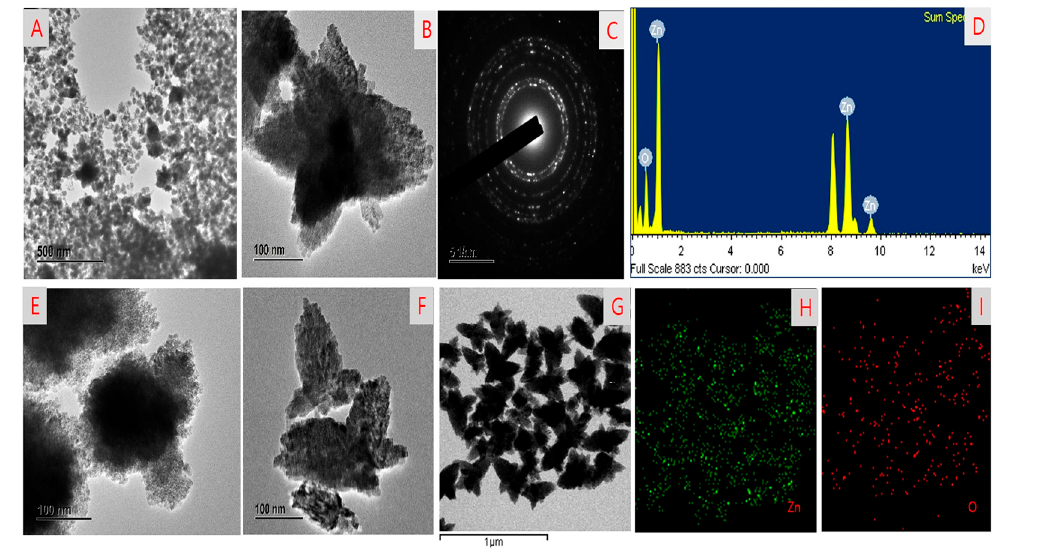
Figure 2. FE-TEM images showing the morphology of ( A , E ) HGR-ZnO NPs without CMC; ( B , F , G ) ZnO NPs with CMC; ( C ) SAED results; ( D ) EDX results; and ( H , I ) elemental mapping of HGRCm-ZnO NPs.